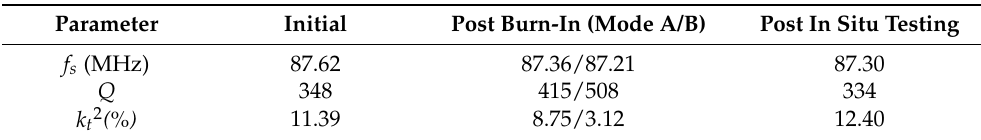
Table 2. Extracted key parameter values initially, post burn-in and post in situ testing as shown in Figure